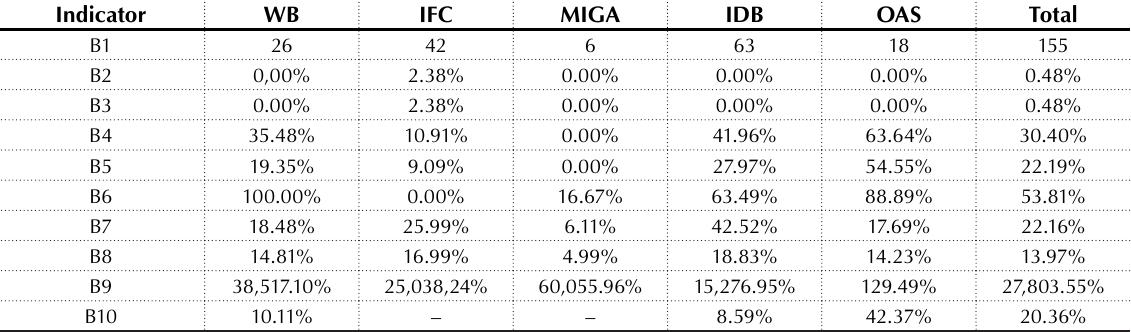
Table 9. Indicators of the scope and growth of the portfolio of clients and end beneficiaries of the funding,